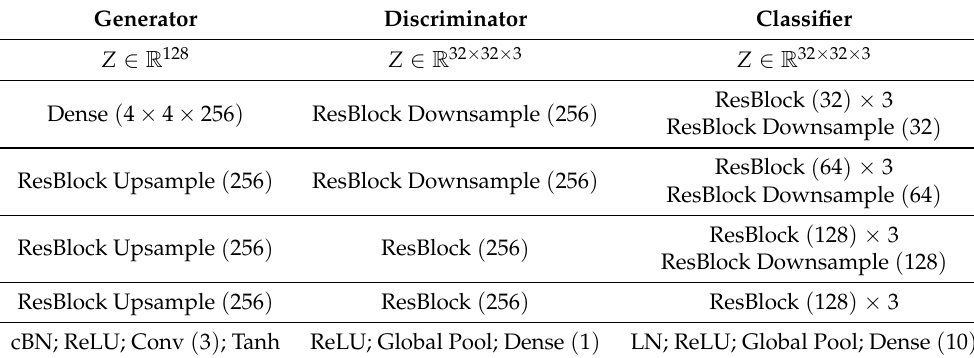
Table 1. Architecture of neural network modules. The values in the brackets indicate the number of convolutional filters or nodes of the layers. Each ResBlock is composed of two convolutional layers with pre-activation functions.